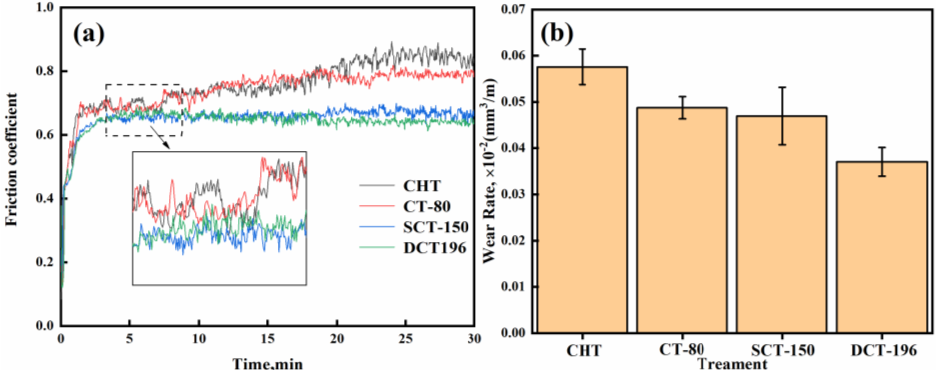
Figure 8. Friction coefficient versus time of 17Cr2Ni2MoVNb alloy steel at different treatment ( a ) and the wear rate after 30min ( b ).